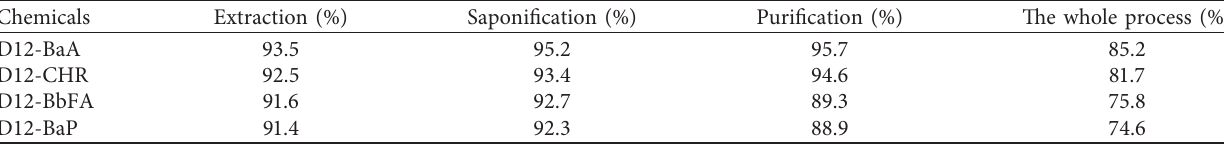
Table 2: Recovery of internal standard during the extraction, saponification, purification, and the whole processes.